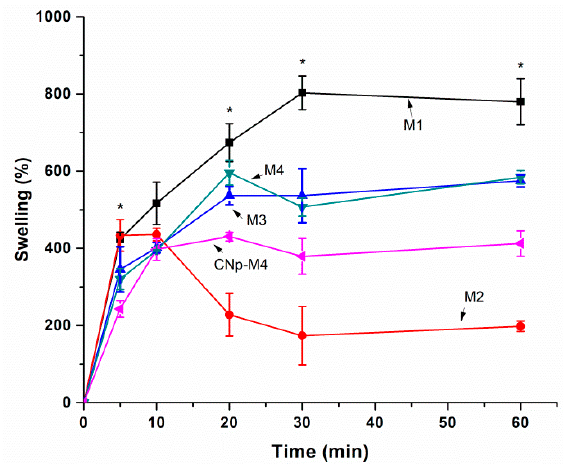
Figure 2. Percentage of swelling in alginate membranes as a function of time. Effect on swelling capacity by the addition of PVA + glycerin ( M1 ), PVA + glycerin + propylene glycol ( M2 ), PVP + glycerin ( M3 ), PVP + glycerin + propylene glycol ( M4 ), and CNp + PVP + glycerin + propylene glycol ( CNp-M4 ) (mean ± SE; n = 3). There were significant differences when ANOVA was applied at 5, 20, 30, and 60 min ( p < 0.05).